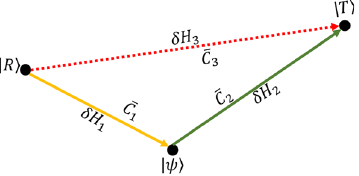
Fig. 4 Schematic explanation about the proof of triangle